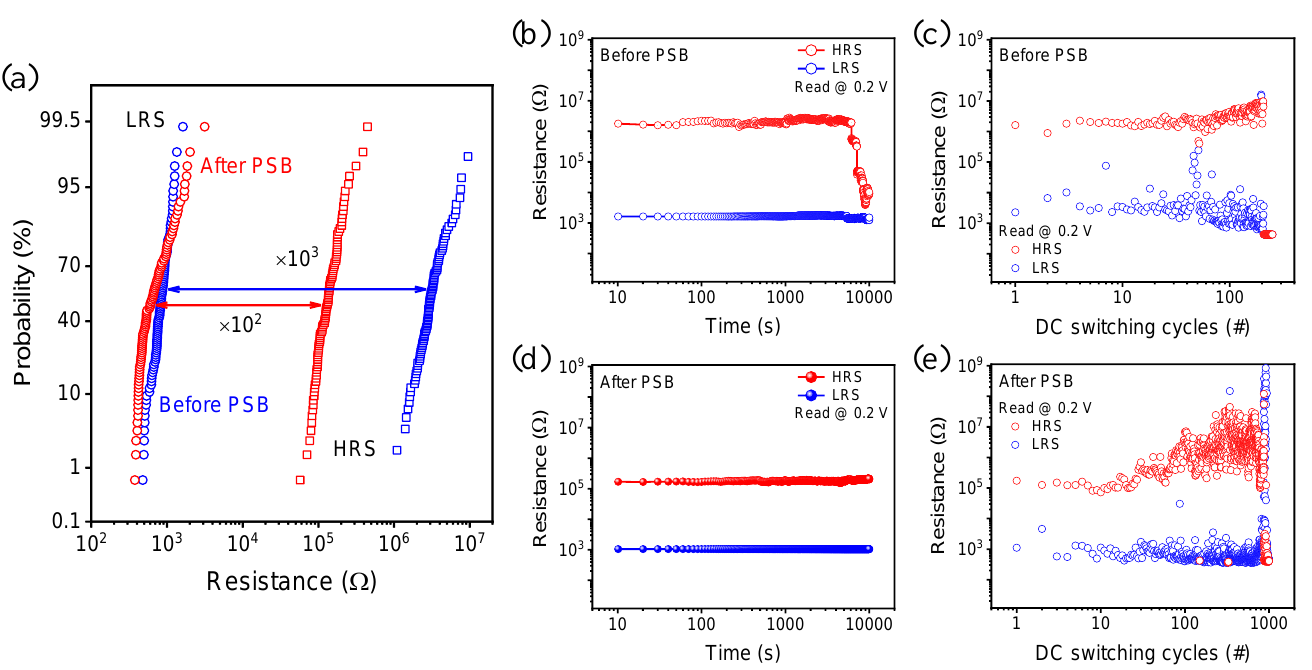
Figure 3. ( a ) Cumulative probability of each state resistance (blue line indicates before PSB, red line indicates after PSB). ( b ) Retention and ( c ) endurance for 250 cycles using a read voltage of 0.2 V before PSB. ( d ) Retention and ( e ) endurance for 1000 cycles tested after PSB.